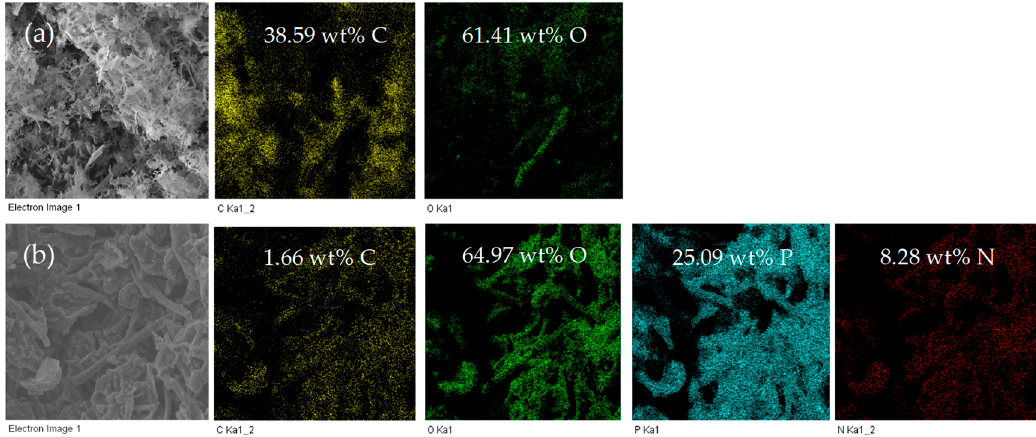
Figure 8. SEM-EDS analyses of char residues from combustion of HDPE composites with ( a ) 7 wt % untreated cellulose, and ( b ) 7 wt % P,N-doped cellulose.